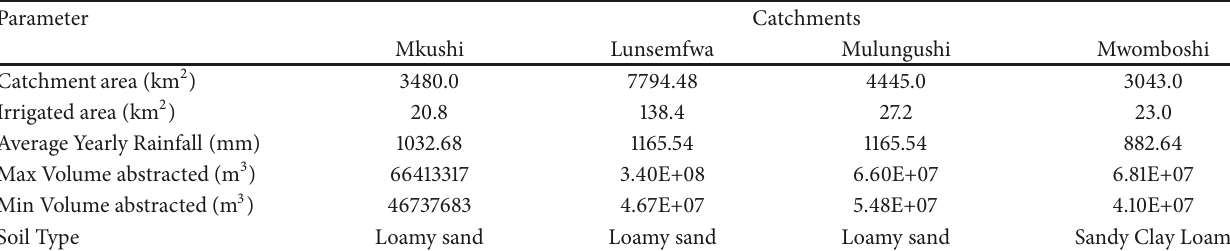
Figure 3: Yearly analysis of net irrigation per hectare and evapotranspiration from soybean and wheat in Mkushi, Lunsemfwa, Mulungushi, and Mwomboshi catchments. Table 5: Parameter of study